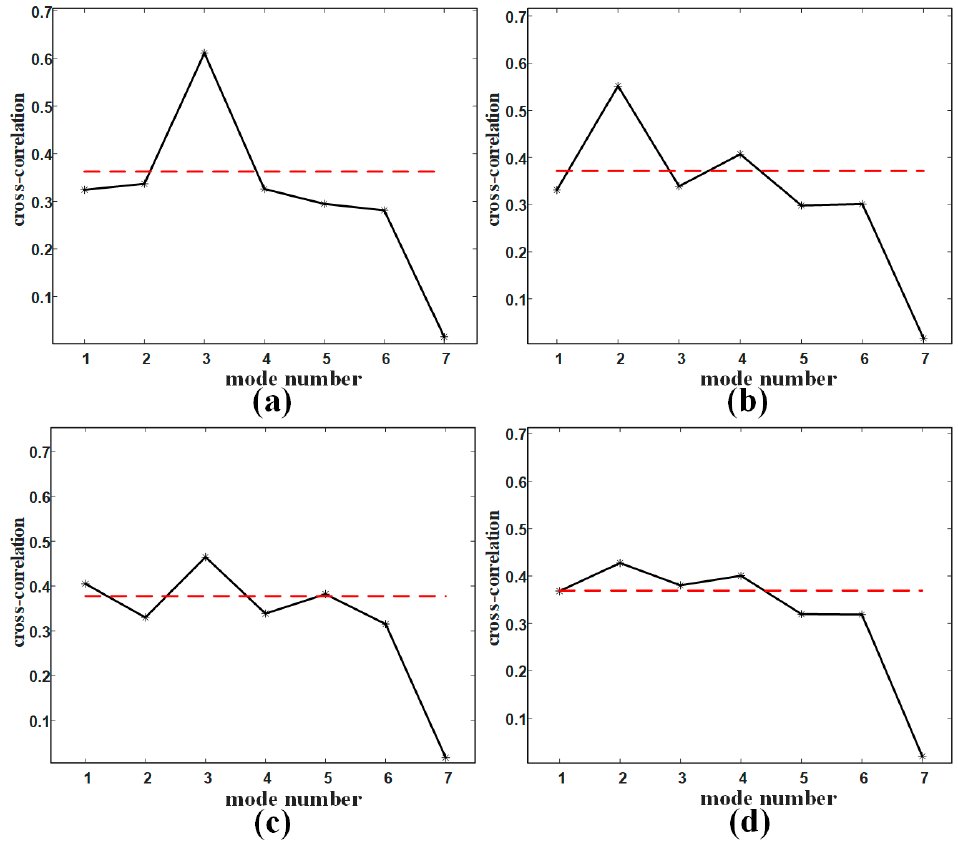
Figure 8. Mode selection results in four cases: ( a ) Single target with SCR = − 15 dB; ( b ) Two targets with SCR = − 15 dB; ( c ) Single target with SCR = − 20 dB; ( d ) Two targets with SCR = − 20